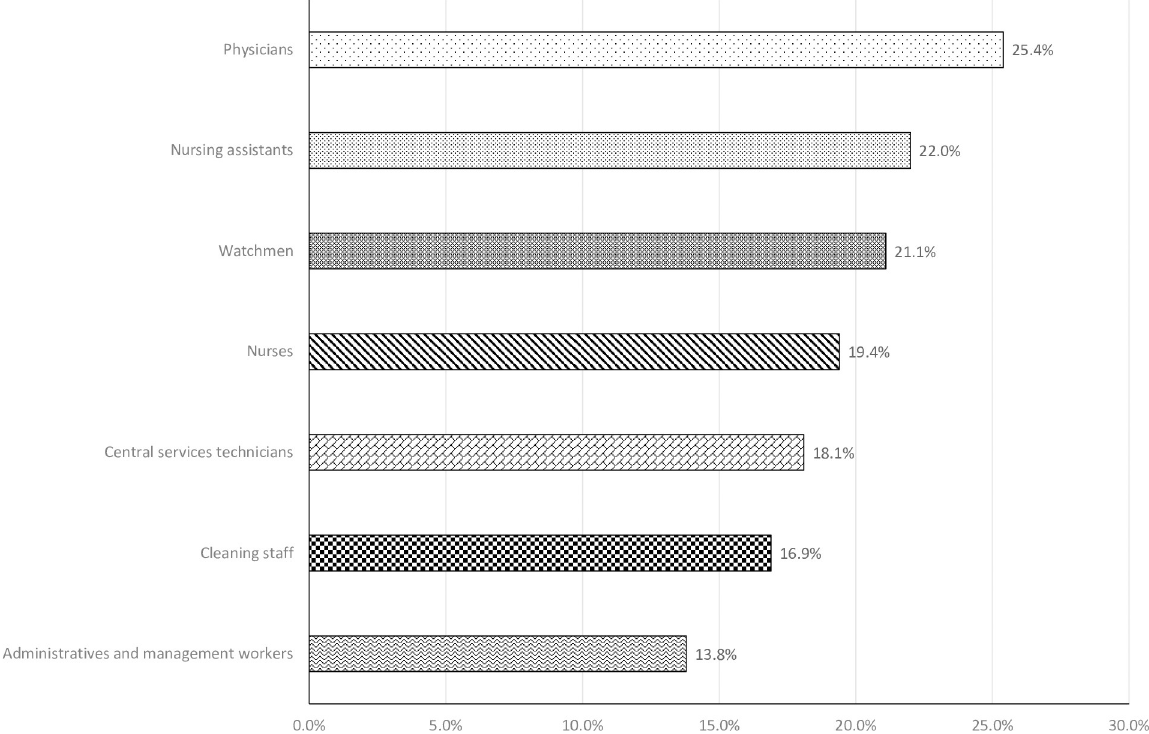
Fig 4. Cumulative prevalence of SARS-CoV-2 cases (IgG positive and/or RT-PCR positive) by professional category. Differences were significant (p < 0.05).